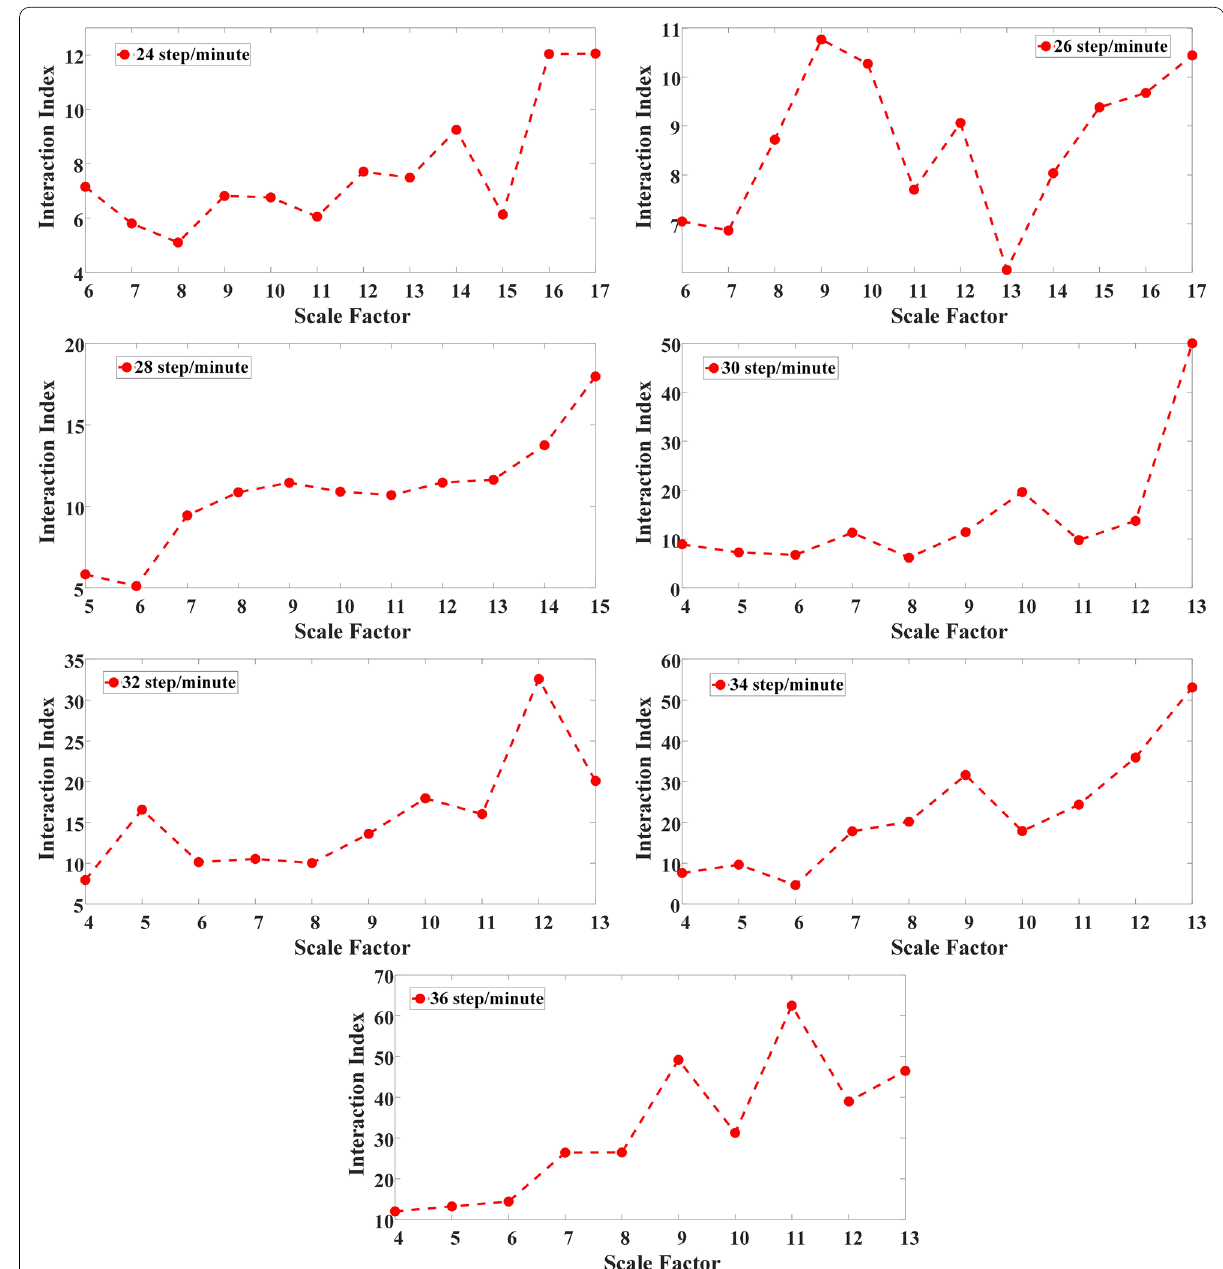
Figure 7 Human-robot interaction index of the admittance control by statistical experiment